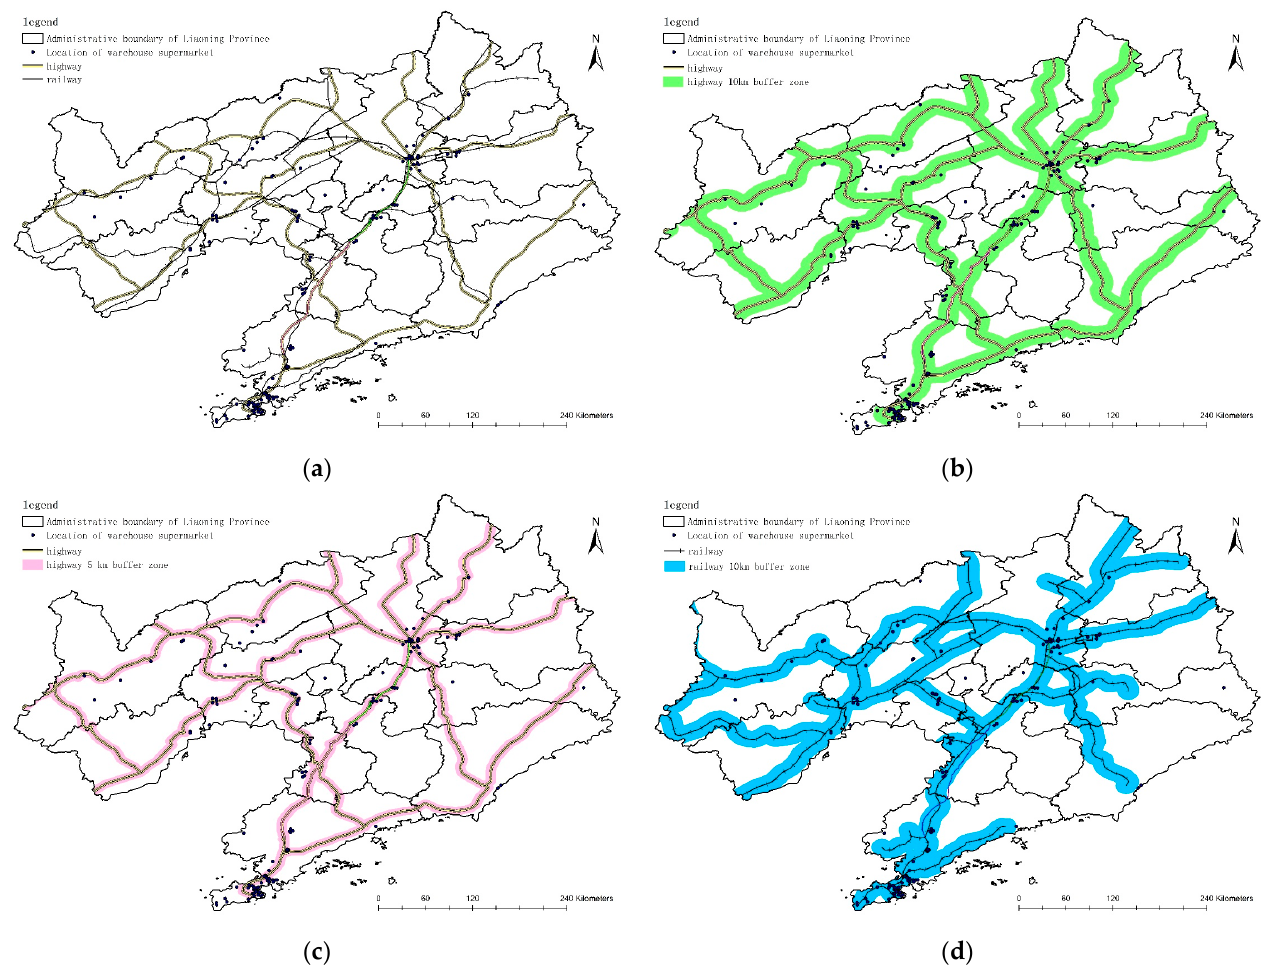
Figure 10. Schematic Diagram of Highway and Railway Distribution, and Buffer Zone in Liaoning Province. ( a ) Main traffic routes in Liaoning Province. ( b ) The 10 km highway buffer zone in Liaoning Province. ( c ) The 5 km highway buffer zone in Liaoning Province. ( d ) The 10 km railway buffer zone in Liaoning Province.